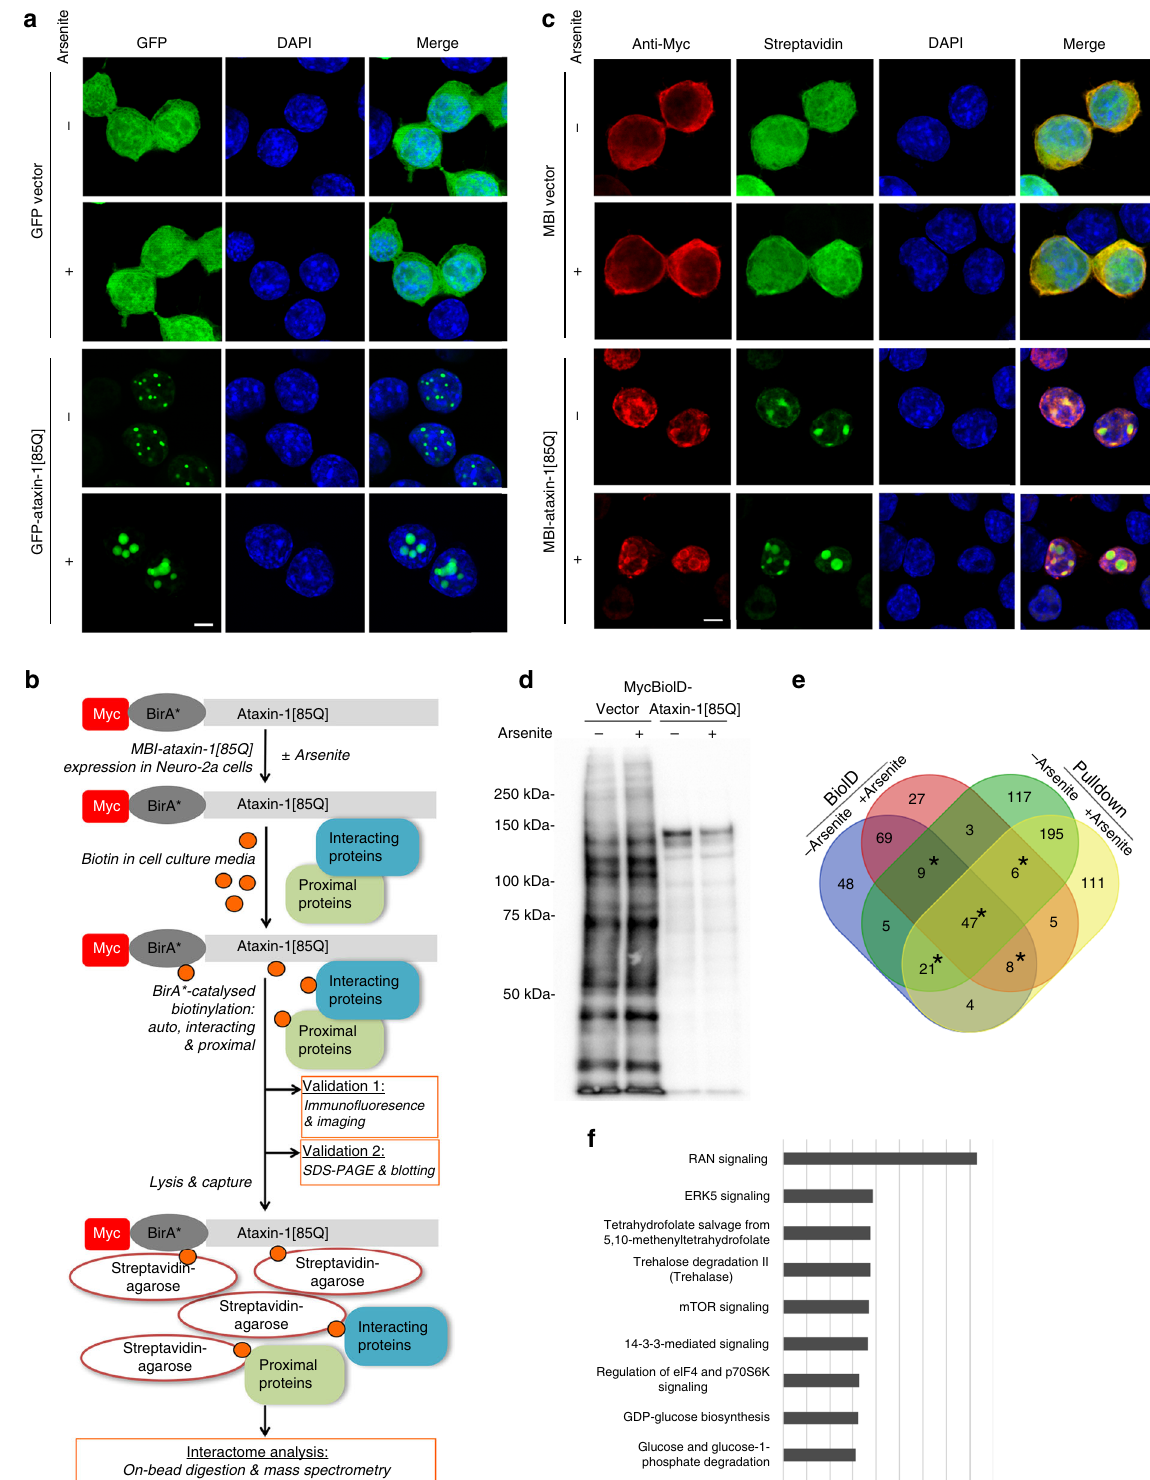
biotinylation during incubation with biotin driven by MBI alone, or pulldown by GFP only, respectively). The result of this multi- step analysis was a total of 675 proteins (Supplementary Data 1). This extends the breadth of the interactome of polyQ-ataxin-1, as previously investigated by proteins co-immunoprecipitating